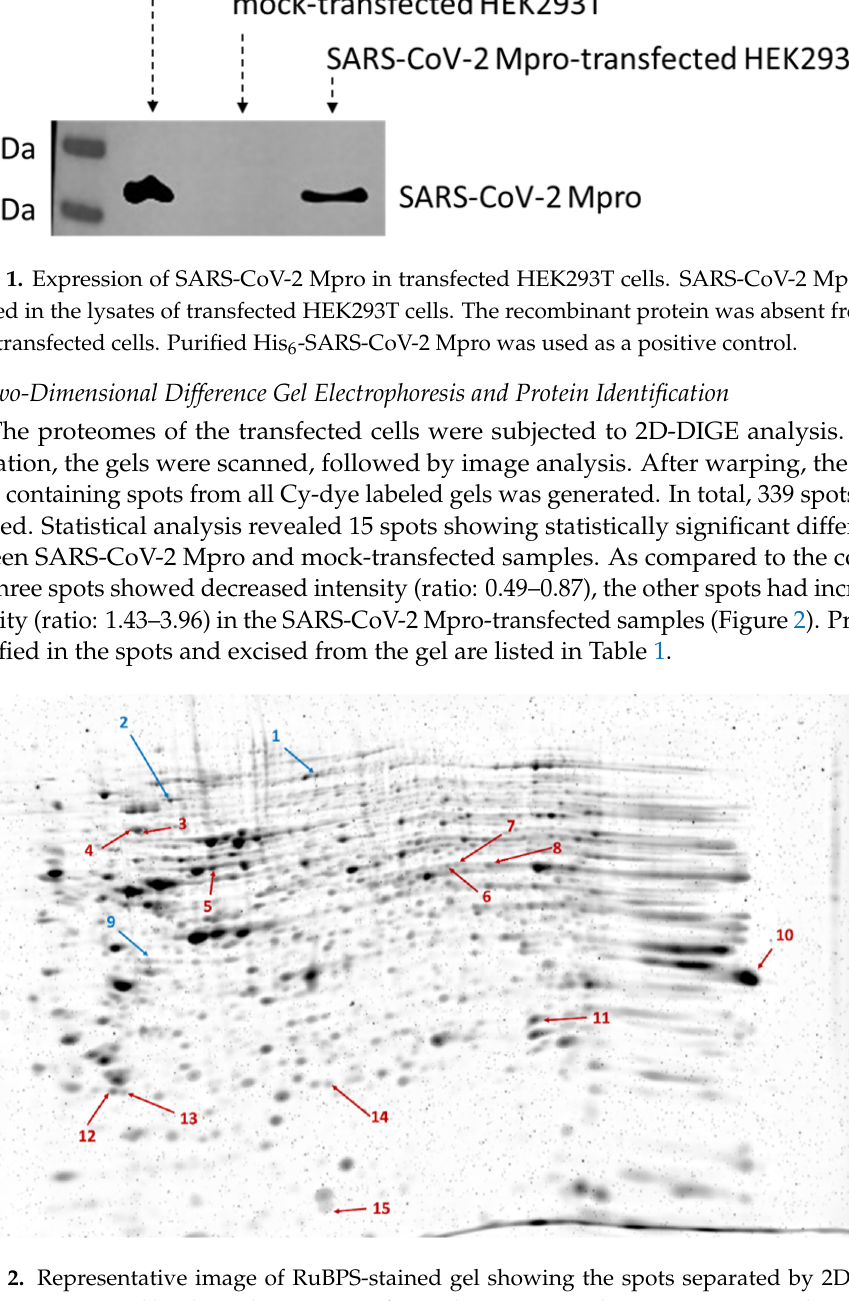
Figure 2. Representative image of RuBPS-stained gel showing the spots separated by 2DE. The image was generated by the Delta2D 4.8.2 software by warping gel images. Arrows indicate spots with significantly decreased (blue) or increased (red) intensity in SARS-CoV-2 Mpro-transfected cells compared to those of mock-transfected cells, based on the analysis of three parallel gels. Table 1. Predicted cleavage sites of SARS-CoV-2 Mpro in cleavage sites in potential substrates iden- tified by 2D-DIGE. Proteins identified in the spots with statistically significant differences between mock- and SARS-CoV-2 Mpro-transfected cells are listed. The name of the proteins and the unique identifiers are shown based on the UniProt database. The cleavage sites were predicted using NetCorona and 3CLP web servers. Potential cleavage sites which were identified by both methods are highlighted with a light green background, while the light orange background indicates that